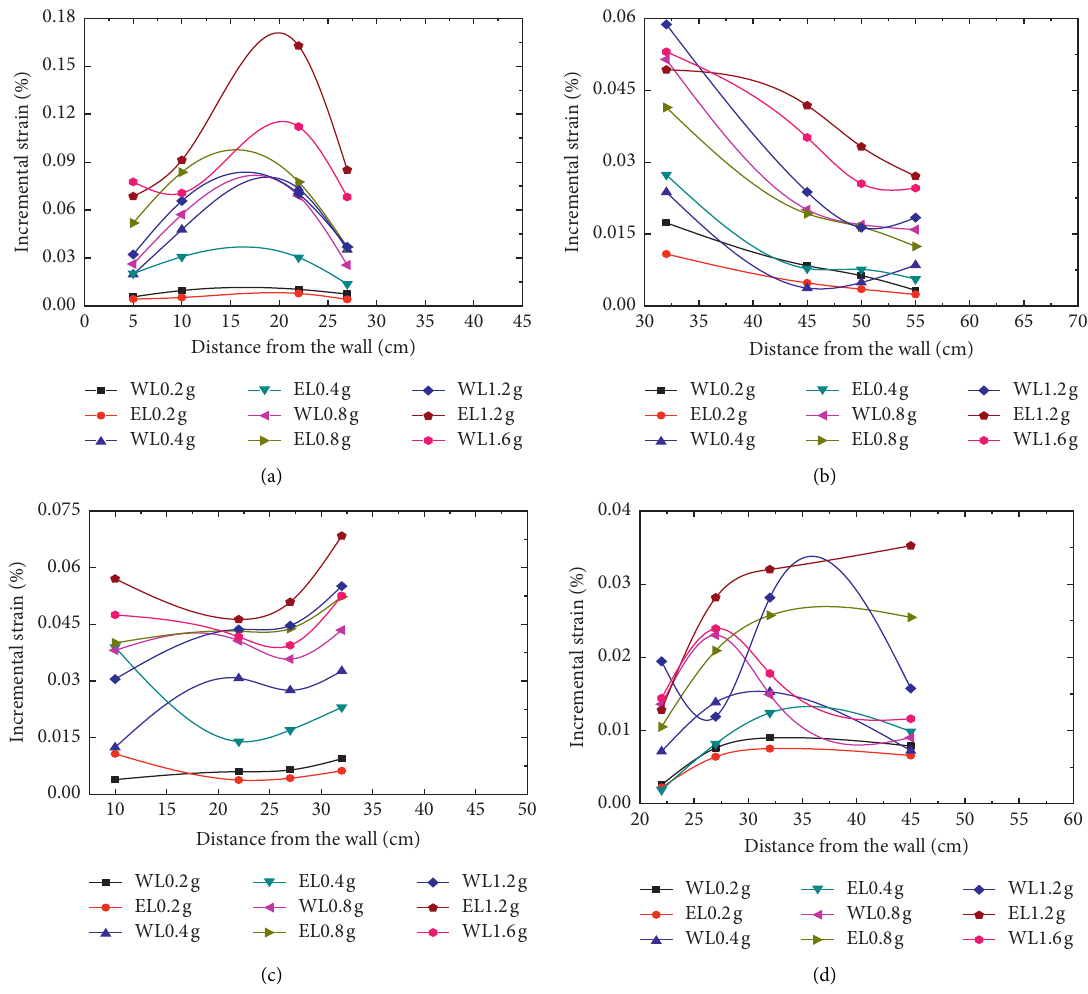
Figure 10: Distributions of strain in different layers for specimen 1. (a) L 1. (b) L 2. (c) L 3. (d) L 4.